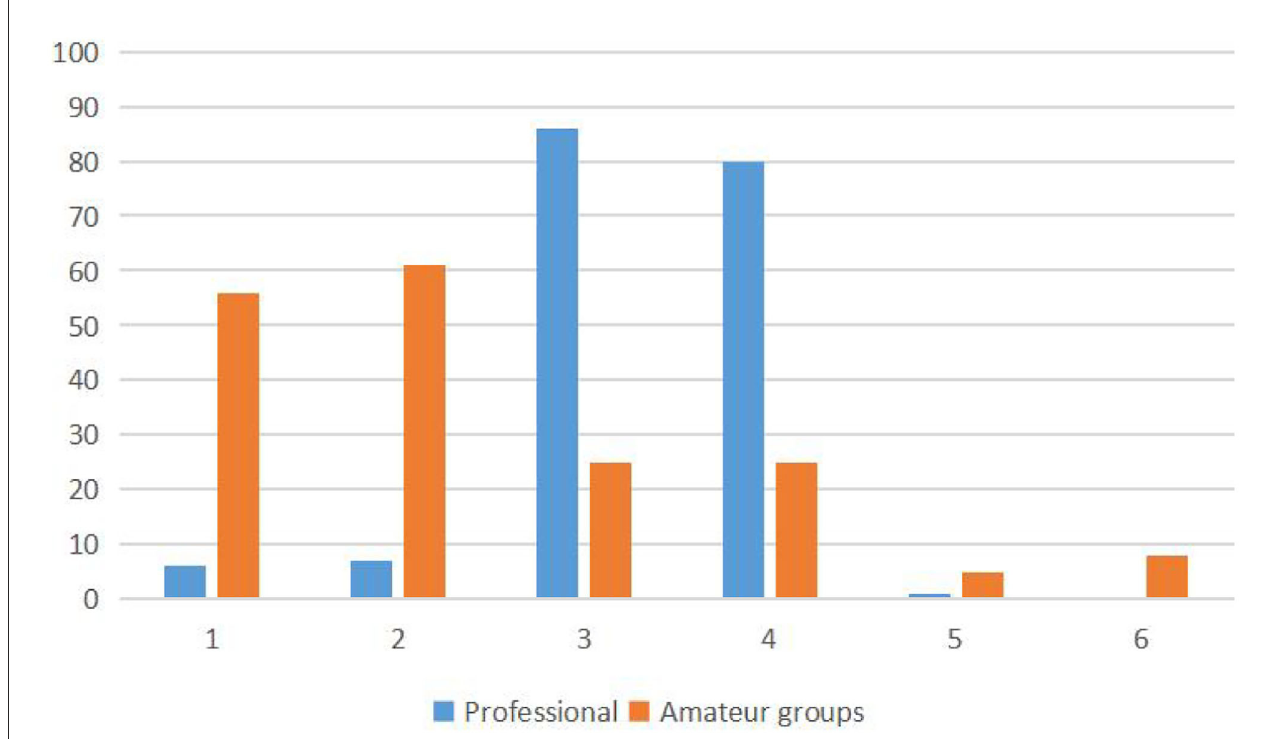
FIGURE4 The total fixation frequency of the different regions of interest in the cognitive decision-making task between the two groups.